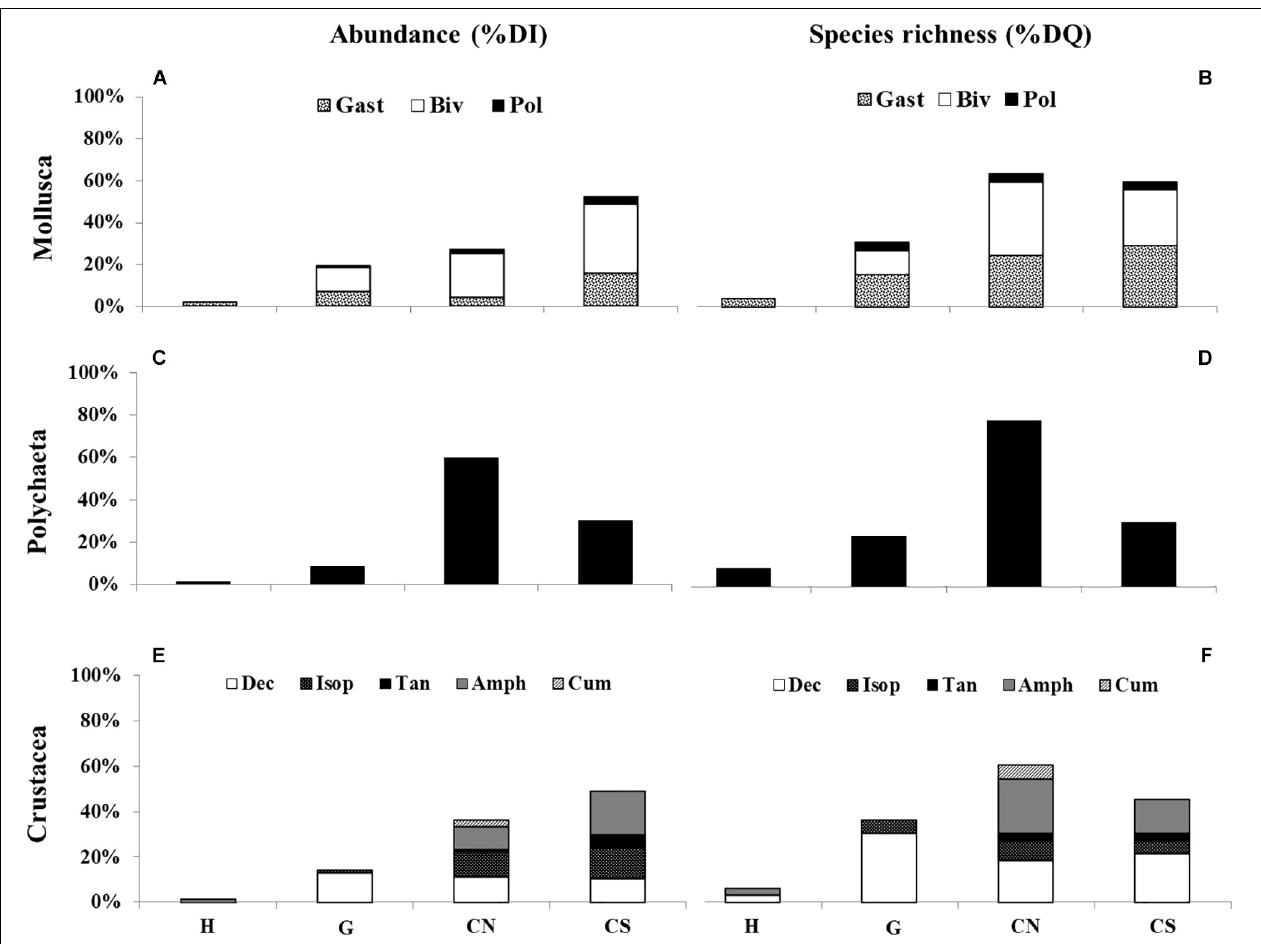
FIGURE 5 | Total contribution to quantitative (Abundance -%DI) and qualitative (Species richness -%DQ) dominances of three taxonomic groups: Mollusca [ (A,B) Gastropoda (Gast); Bivalvia (Biv); Polyplacophora (Pol)], Polychaeta (C,D) and Crustacea [ (E,F) Decapoda (Dec); Isopoda (Isop); Tanaidacea (Tan); Amphipoda (Amph); Cumacea (Cum)] for each site (H; G; CN; CS).